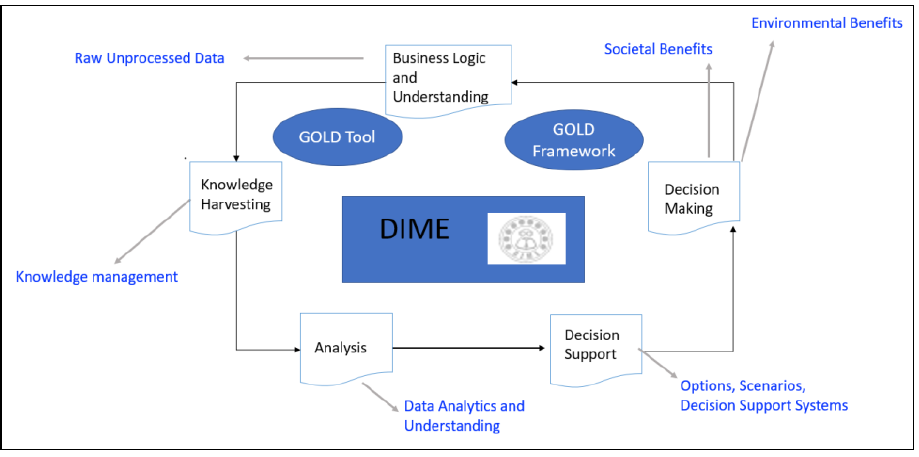
Fig 1 . The five steps of the DSL design and use – using